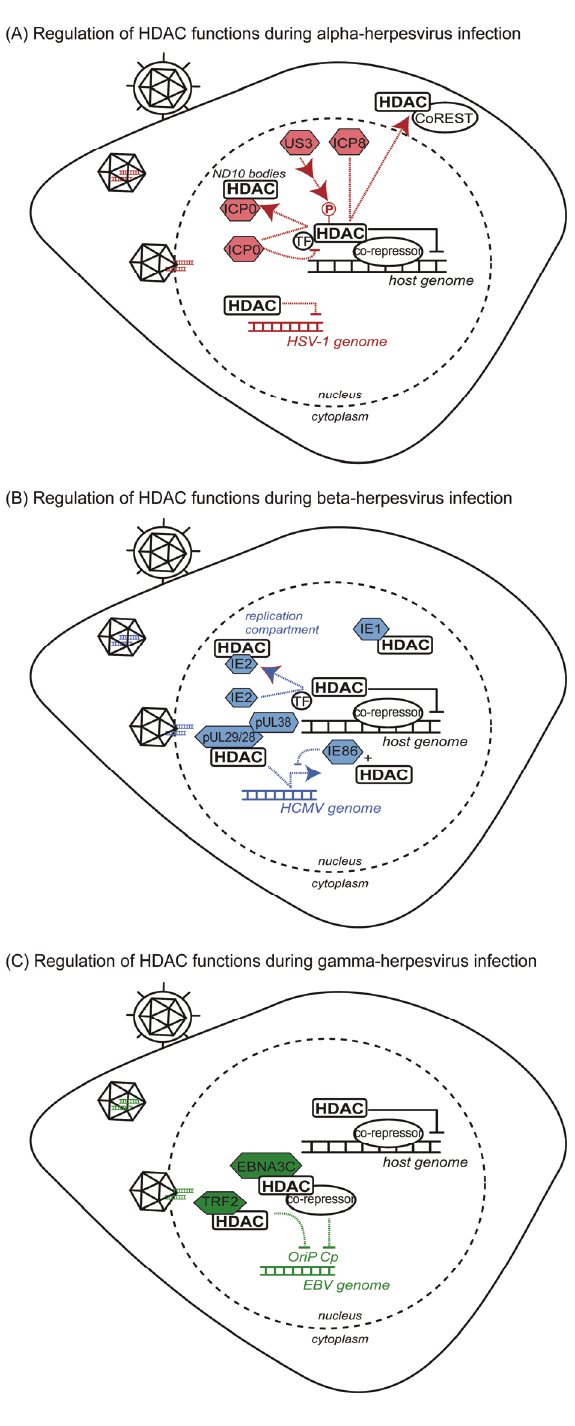
Figure 1. Summary of HDAC functions during herpesvirus infection. ( A ) Response to alpha-herpesvirus infection (HSV-1); ( B ) response to beta-herpesvirus infection (HCMV); ( C ) response to gamma-herpesvirus infection (EBV and